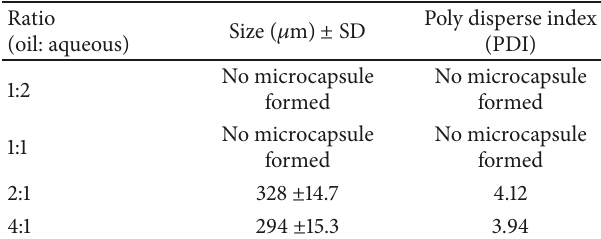
Table 1: Effect of oil and aqueous phase ratio on microcapsule